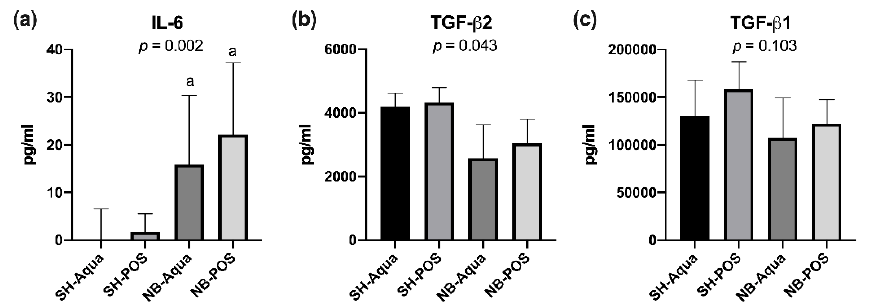
Figure 2. Serum levels of ( a ) IL-6, ( b ) TGF- β 2, and ( c ) TGF- β 1. NB—neuroblastoma; SH—sham; POS—prebiotic oligosaccharide; a— p < 0.05 vs. SH-Aqua.